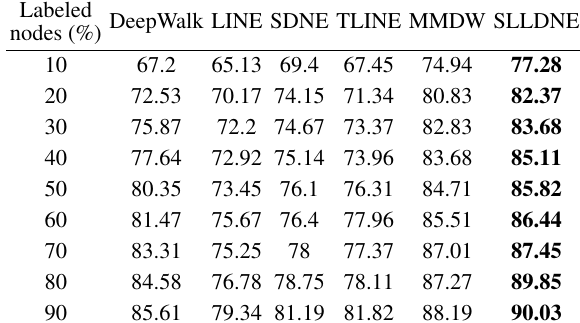
Table 4 Micro-F1 (%) of vertex classification on